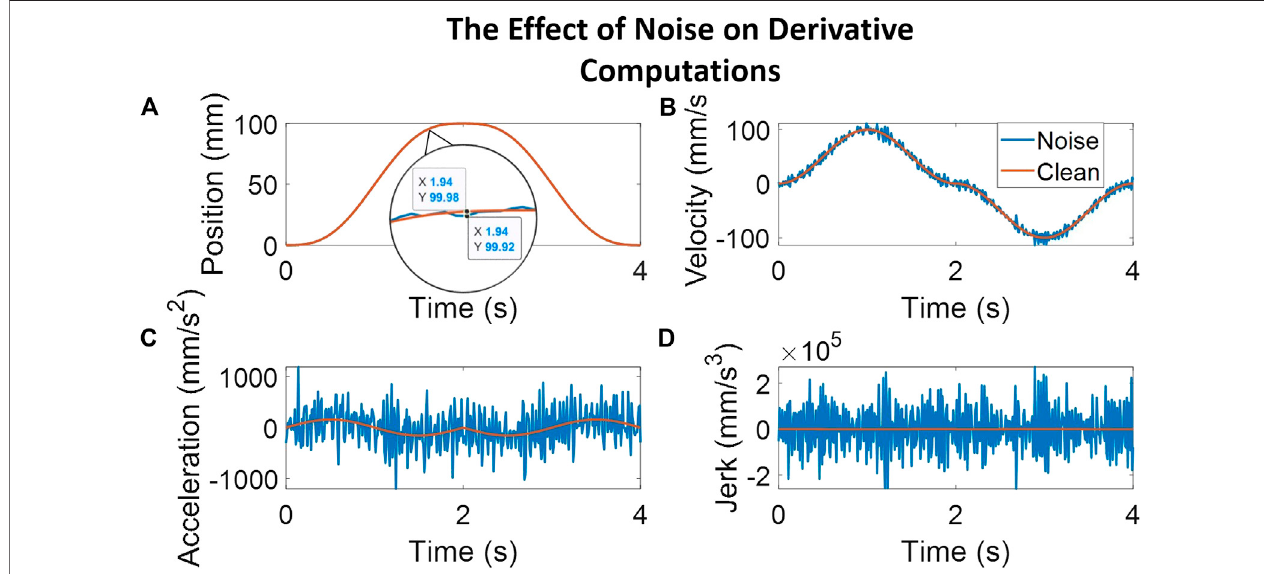
FIGURE 2 | Illustrated sketch of the simulator with a few of the various sensors alongside a physical example of subject receiving fl ashback. A needle approaches one of the four fi stulas. t entry occurs when the needle punctures the fi stula.